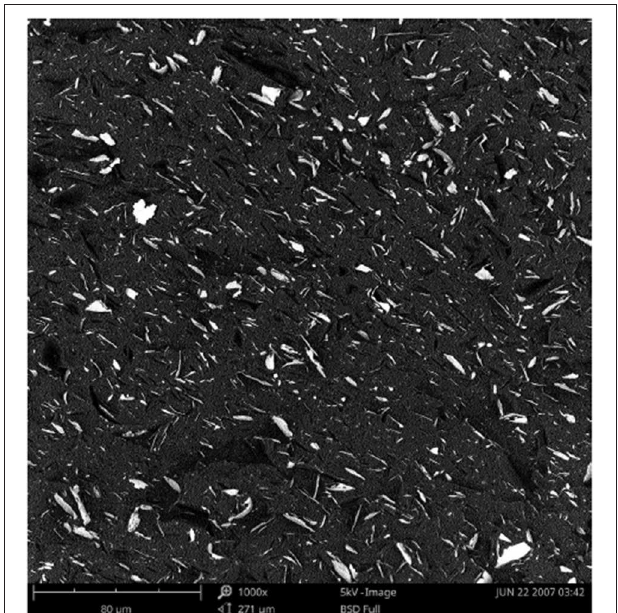
FIGURE 7 | Typical SEM micrograph of a cryogenic fracture surface of the Cu-filled PLA undrawn